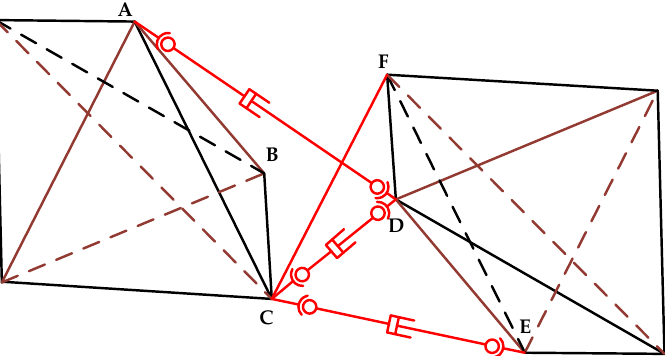
Figure 4. The center branch and drive branch axis of three rotational motions. The red circle repre- sents the ball joint. The red square represents the mobile pair.